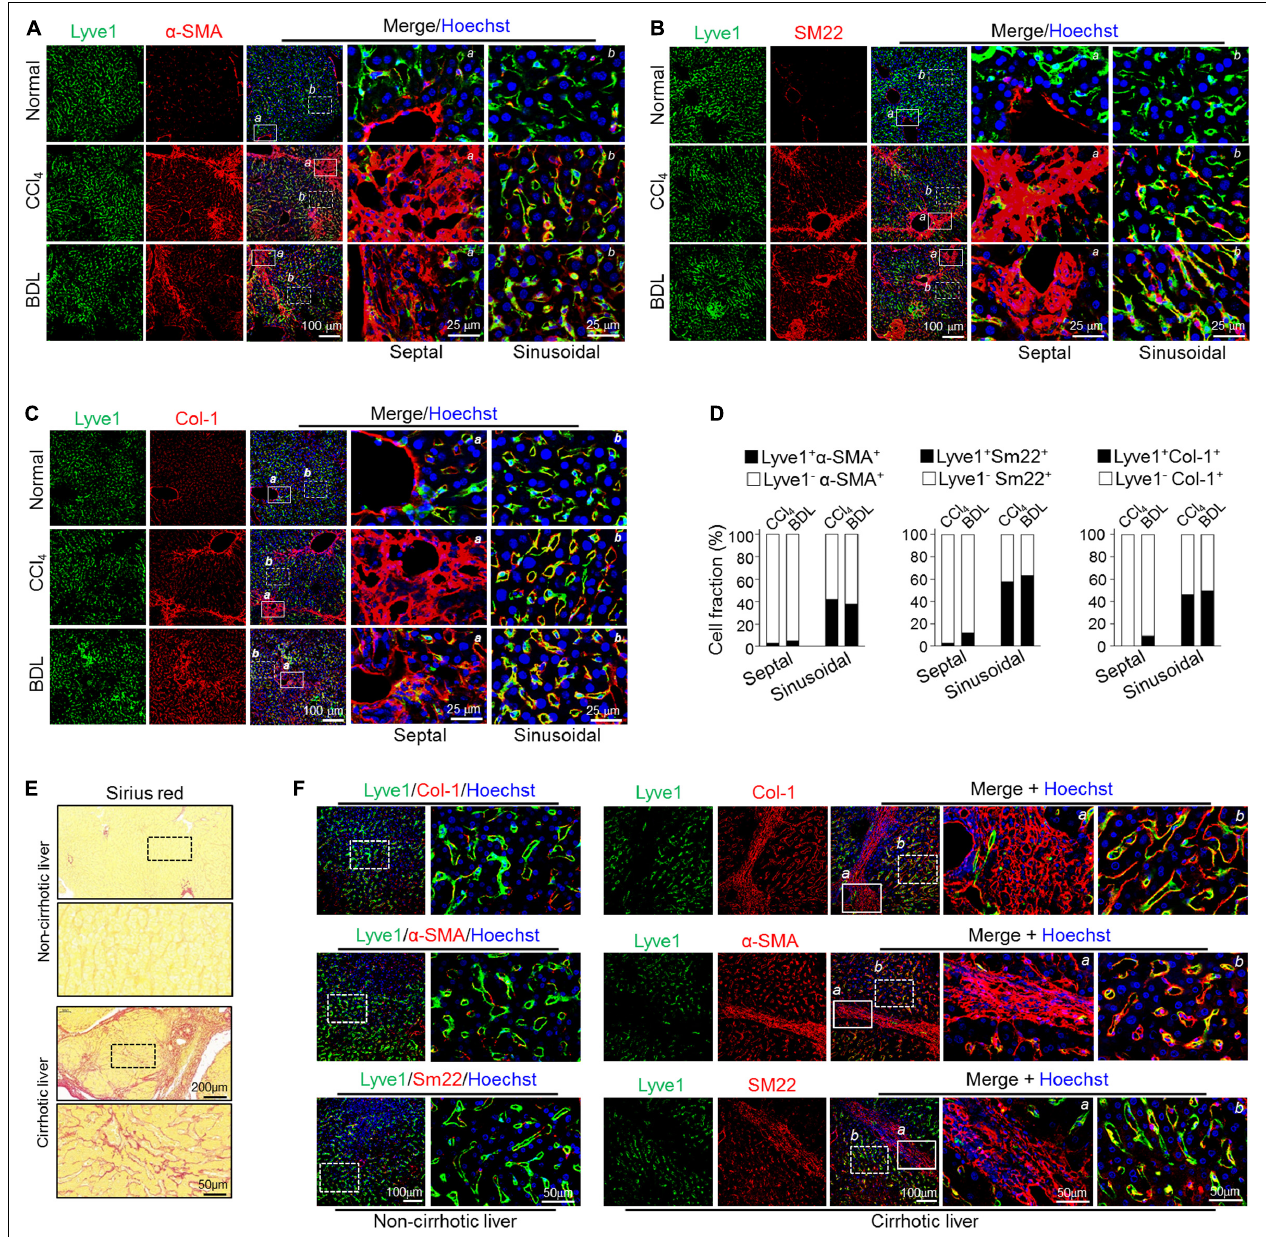
FIGURE 4 | Mesenchymal-transited LSECs mainly contribute to sinusoidal but not septal/portal ECM deposition in liver fibrogenesis. (A–C) Mice were subjected to CCl 4 - or BDL-induced liver fibrosis ( n = 3–4). Liver cryosections were stained for Lyve1 plus α -SMA (A), SM22 (B), or Col-1 (C) with nuclei counterstained with Hoechst. Representative septal/portal areas ( a , box with solid lines) and sinusoidal areas ( b , box with dotted lines) are shown at higher magnification. (D) Cell fractions of Lyve1 + mesenchymal ( α -SMA + /SM22 + /Col-1 + ) cells between the septal and the sinusoidal areas are shown. (E) Representative Sirius red staining showing sinusoidal fibrogenesis in human cirrhotic liver sections ( n = 3 for healthy liver and n = 8 for cirrhotic liver). (F) Human non-cirrhotic and cirrhotic liver sections were stained for Lyve1 and MF markers (Col-1, α -SMA, and SM22). Representative septal areas ( a , box with solid lines) and sinusoidal areas ( b , box with dotted lines) are shown at higher